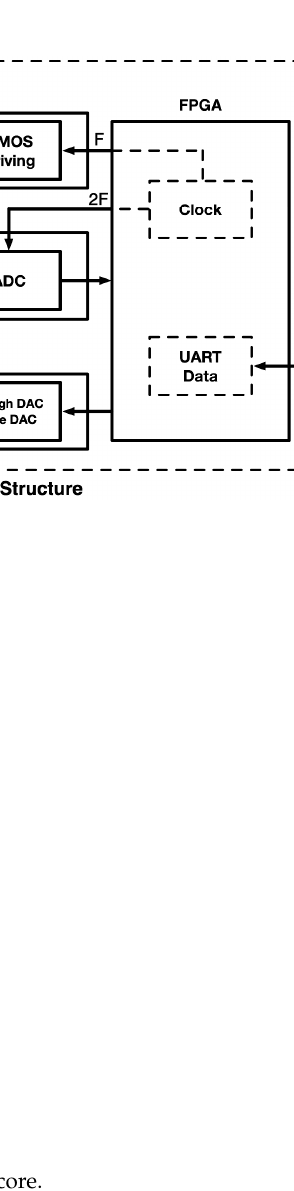
Figure 2. The hysteresis curve of the soft magnetic material core.